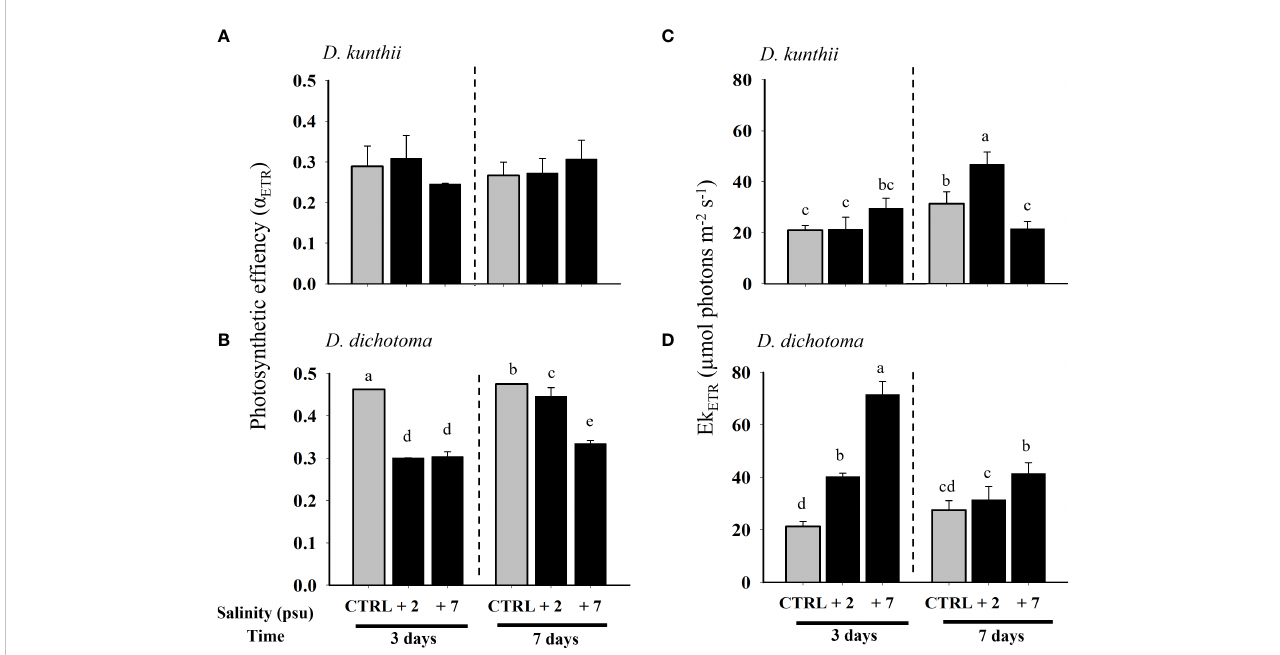
FIGURE 2 Photosynthetic ef fi ciency ( a ETR ) and saturation of irradiance (Ek ETR ) in D. kunthii (A, C) and D. dichotoma (B, D) exposed to high salinity values. For D. kunthii , the salinity values were 35 psu (control), 37 psu (+2), and 42 (+7) psu; for D. dichotoma , these were 37 psu (control), 39 (+2) psu, and 44 (+7) psu. The samples were analyzed after 3 and 7 days. Data corresponds to mean ± SD ( n = 3). Letters represent statistical difference at 95% con fi dence interval (Student – Newman – Keuls test, p < 0.05). No letters mean no signi fi cant